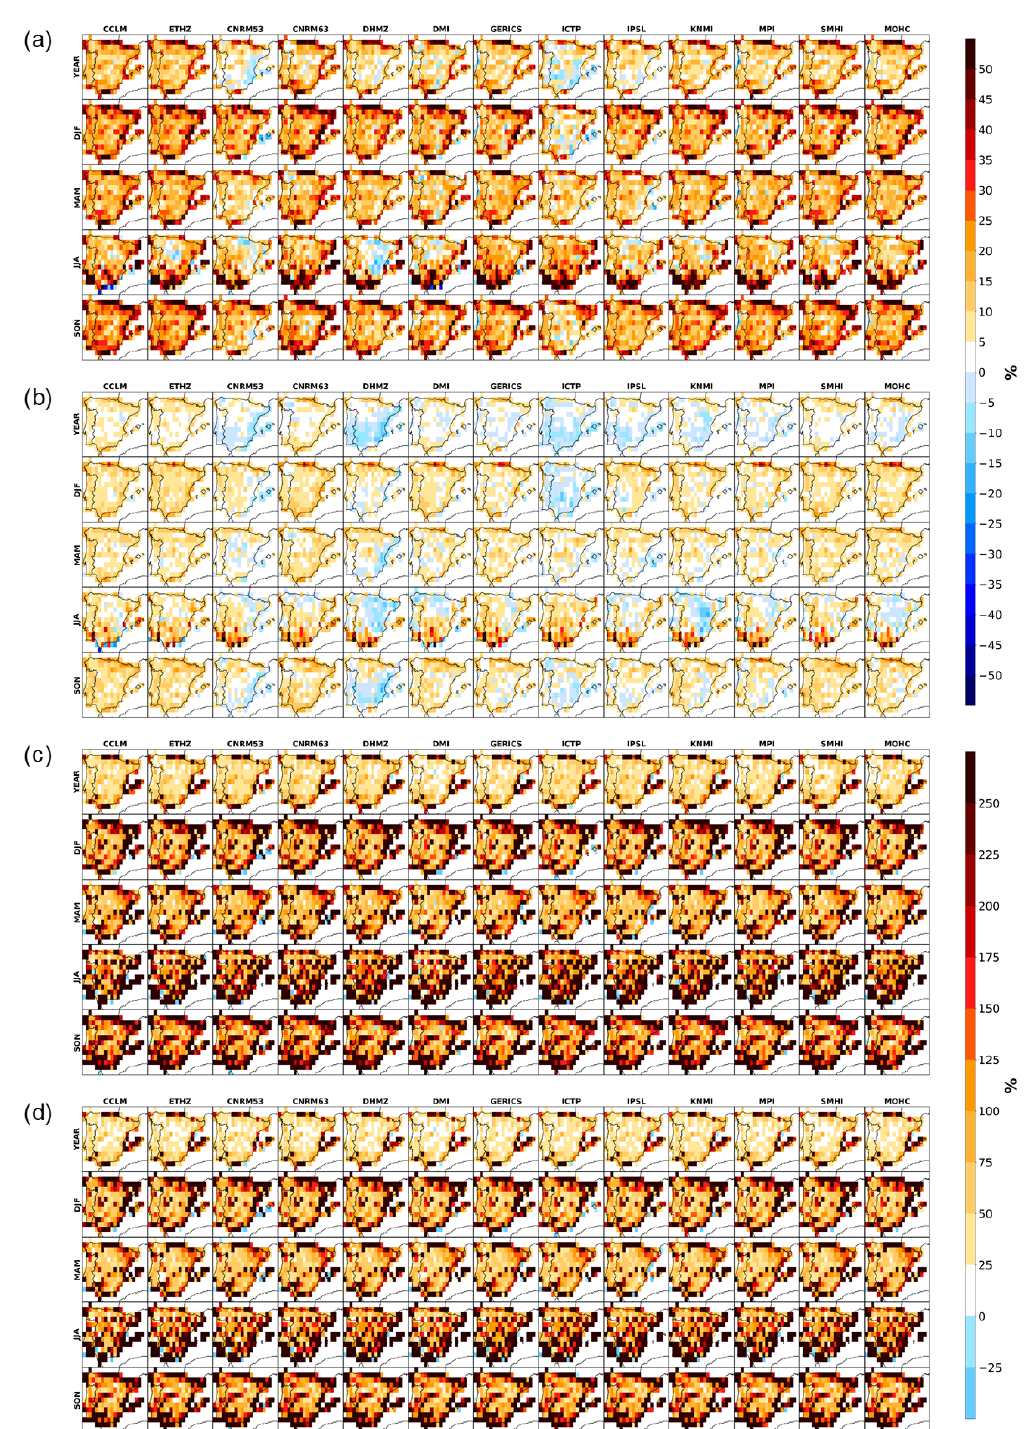
Figure 3. Yearly and seasonal spatial distribution added values (DAVs) of the Iberian Peninsula between the RCMs and the ERA-Interim reanalysis for the 1989–2008 period taken from the hindcast EURO-CORDEX simulations, with the IGD regular dataset as a reference for (a) daily precipitation intensity considering the whole PDF, (b) daily precipitation frequency considering the whole PDF, (c) daily precipitation intensity extremes, only considering the values above the observational 95th percentile from each ERA-Interim grid point, and (d) daily precipitation frequency extremes only considering the values above the observational 95th percentile from each ERA-Interim grid point. All RCM data were previously interpolated to 0.1 ◦ regular resolution from the observations, while the observations were interpolated into the ERA-Interim